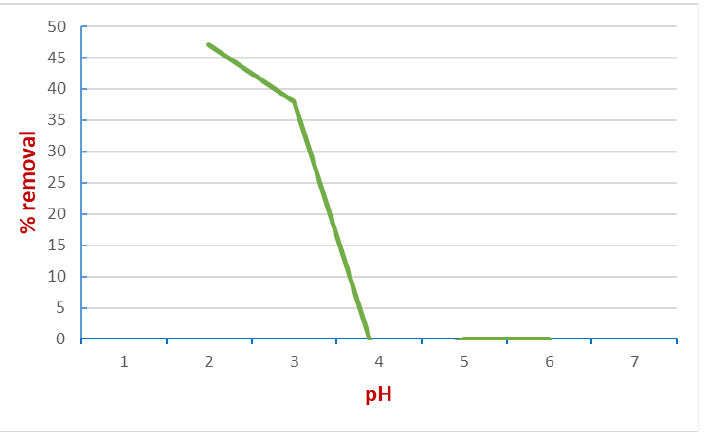
Figure 8. Correlation between pH and removal (%) of the dye at 50 °C; concentration of the dye = 0.09 mM, mass = 10 mg, time = 24 h. Adapted from Reference [48]. Copyright 2007, Elsevier.